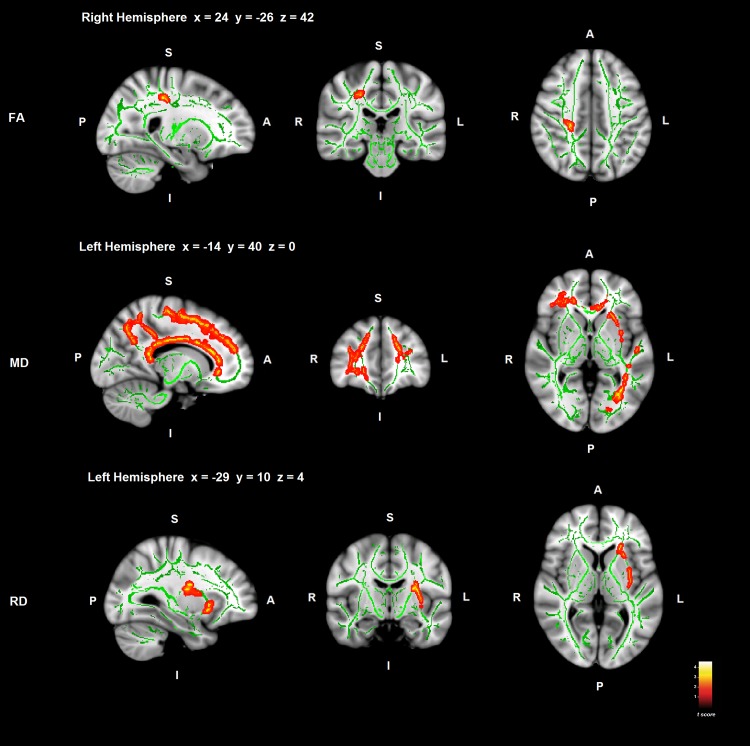
Correlations between ToM deficit and WM in PD.Significant WM regions are shown in red-yellow; the WM skeleton is shown in green. S = superior; I = inferior; A = anterior; P = posterior. Coordinates are shown in MNI space (Montreal Neurological Institute).